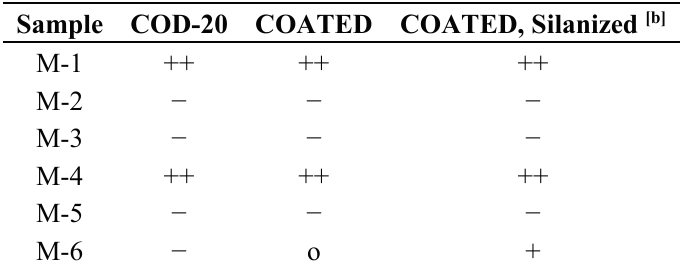
Table 4. Penetration through the separator [a]